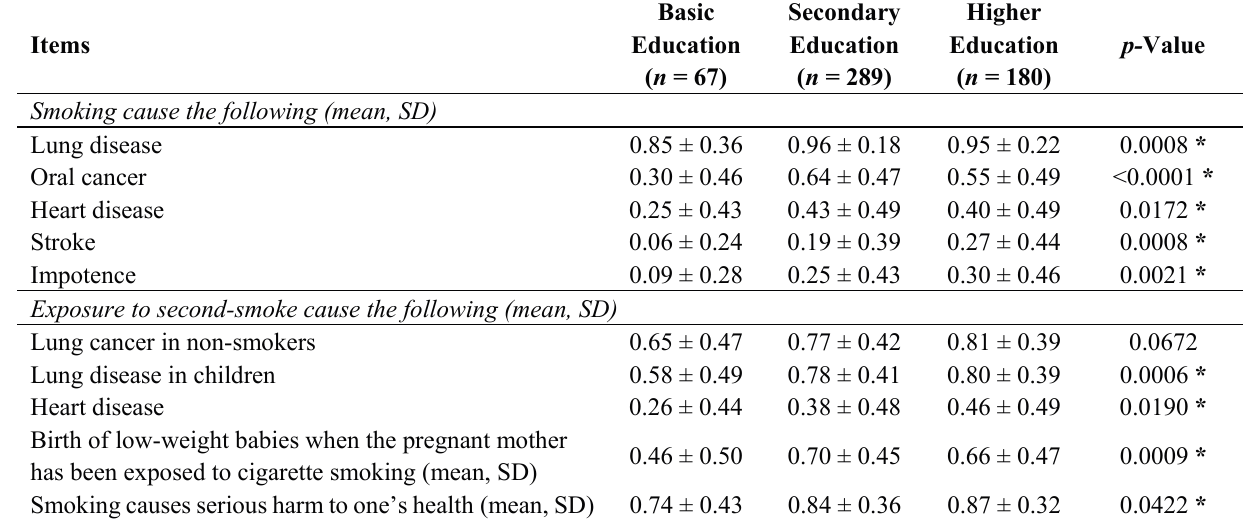
Table 2. Smokers’ cognition of smoking’s related hazards, Chongqing, China,